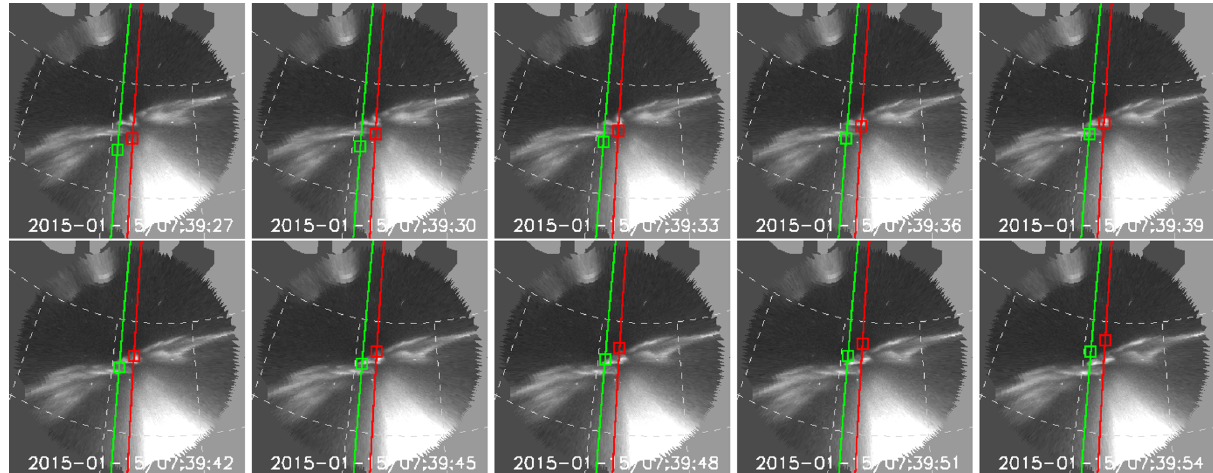
Figure 7. Mapped optical frames in geographic coordinates from RANK station. The tracks show the ionospheric projection of SwA (green) and SwC (red). At the time of the frame the spacecraft mapped position is shown by the square symbols. The time is overplotted on each frame and covers the interval from 07:39:27 to 07:39:54.